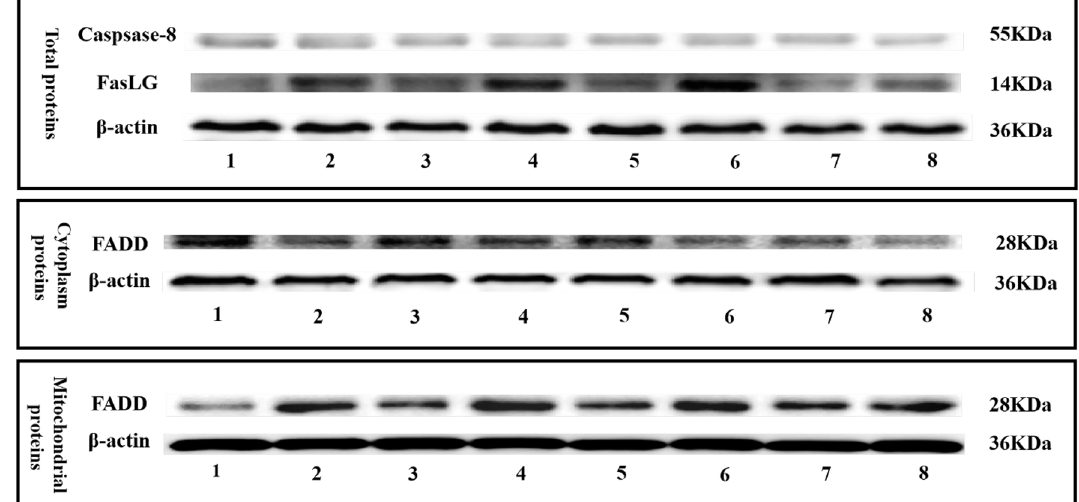
Figure 18. Different treatments induce the translocation of FADD and the activation of caspase-8. IPEC-J2 was treated in different treatments (1. Control treatment (T1); 2. SBA treatment (T9); 3. KRT8-siRNA treatment (T2); 4. KRT8-siRNA + SBA treatment (T10); 5. KRT18-siRNA treatment (T3); 6. KRT18-siRNA + SBA treatment (T11); 7. ACTA-siRNA treatment (T4); and 8. ACTA-siRNA + SBA treatment (T12)) for 24 h.